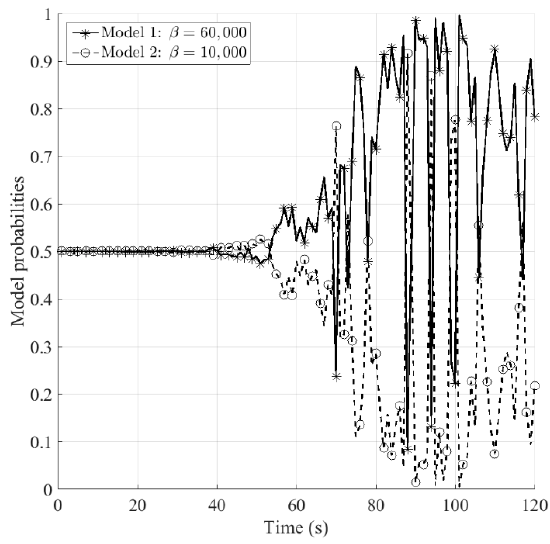
Figure 8. Model probabilities for sensor S 2 .